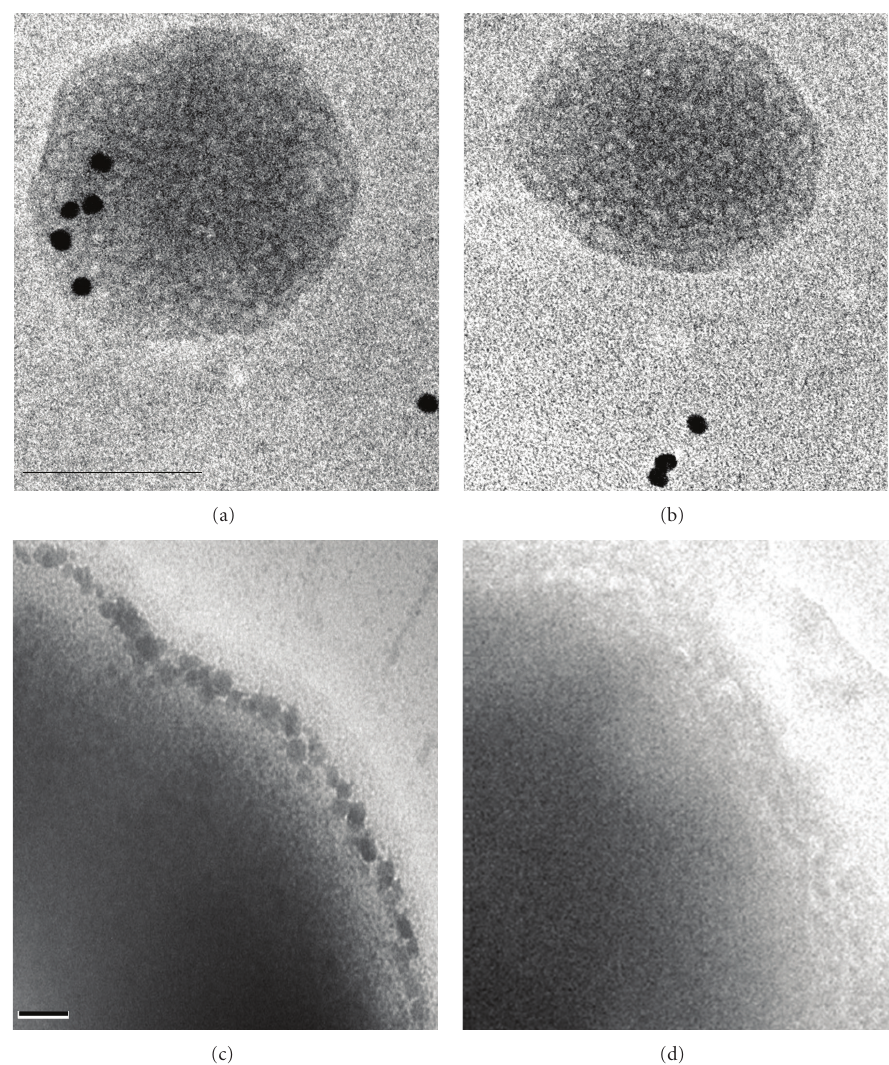
Figure 2: . EF-Tu visualized on A. baumannii OMVs and cells by immune TEM with EF-Tu antibodies. Immunogold TEM with anti-EF-Tu antibodies showing localization of (a) EF-Tu on the isolated OMV and (c) on cell surface of A. baumannii . Immunogold with preimmune serum shows no localization on OMVs (b) and cells (d). n = 40 OMVs. Bar: 100